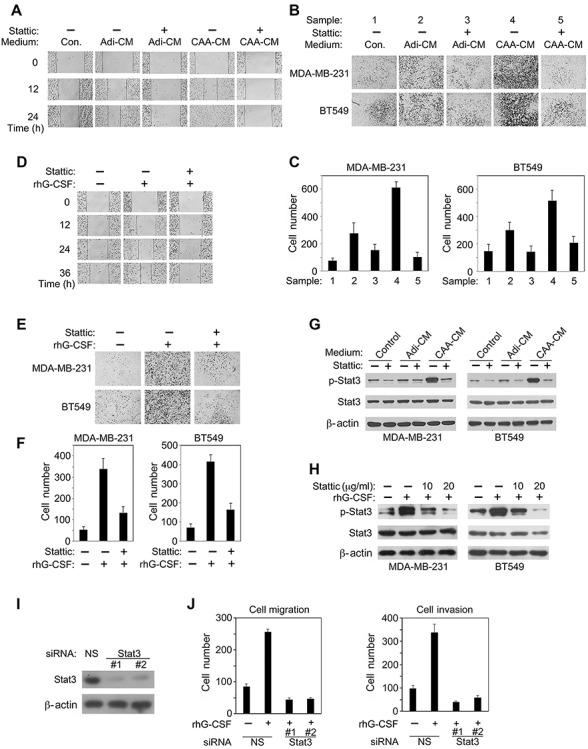
Targeting Stat3 by a small-molecule inhibitor abolishes CAA- and G-CSF-induced TNBC cell migration and invasion. (A–C) TNBC cells cultured in different media were treated with or without 20 μg/ml Stattic as indicated. Migration of MDA-MD-231 cells (A) and matrigel invasion of MDA-MD-231 or BT549 cells (B and C) were determined, respectively. (D–F) TNBC cells were treated with rhG-CSF (20 ng/ml) and Stattic (20 μg/ml) as indicated. Migration of MDA-MD-231 cells (D) and matrigel invasion of MDA-MD-231 or BT549 cells (E and F) were determined, respectively. (G) Cells cultured in different media were treated with or without 20 μg/ml Stattic for 15 min before western blotting for p-Stat3 protein levels. (H) Cells were treated with rhG-CSF and Stattic as indicated for 15 min before western blotting for p-Stat3 protein levels. (I and J) MDA-MB-231 cells transfected with nonspecific (NS) or Stat3-targeting siRNAs were analyzed by western blotting (I) or treated with 20 ng/ml rhG-CSF for 24 h and subjected to cell migration (left) and invasion (right) assays (J). Typical microscopic fields and blots are shown and quantitative data are presented as mean ± SD from at least three independent experiments.